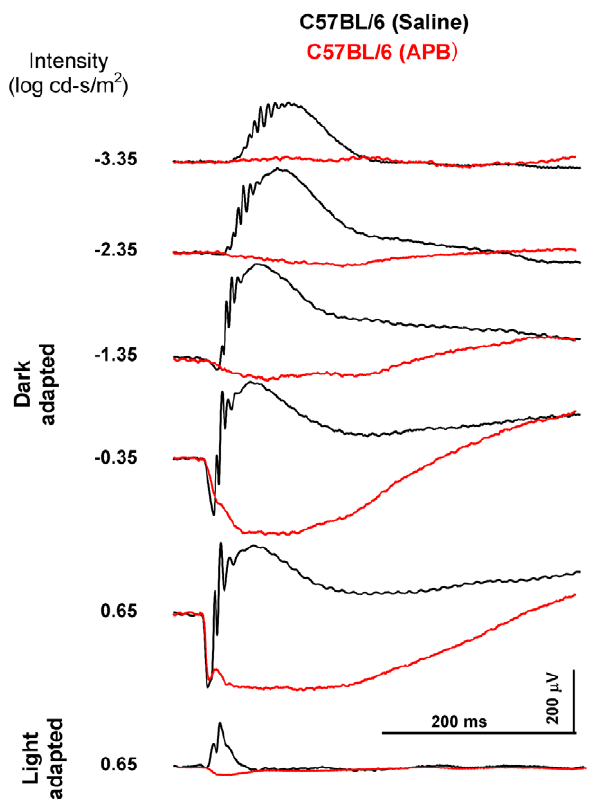
Figure 4. The effect of the ON-channel blocker APB on the dark- and light-adapted ERG in mouse. The black traces show ERGs of the saline-injected control eye and the red traces show ERGs of the APB-injected eye. In the APB-injected eye, the photoreceptor a- wave remains but the b-waves are absent. Loss of the b-waves indicates that APB blocks the signal transmission from the photoreceptors to the ON bipolar cells.